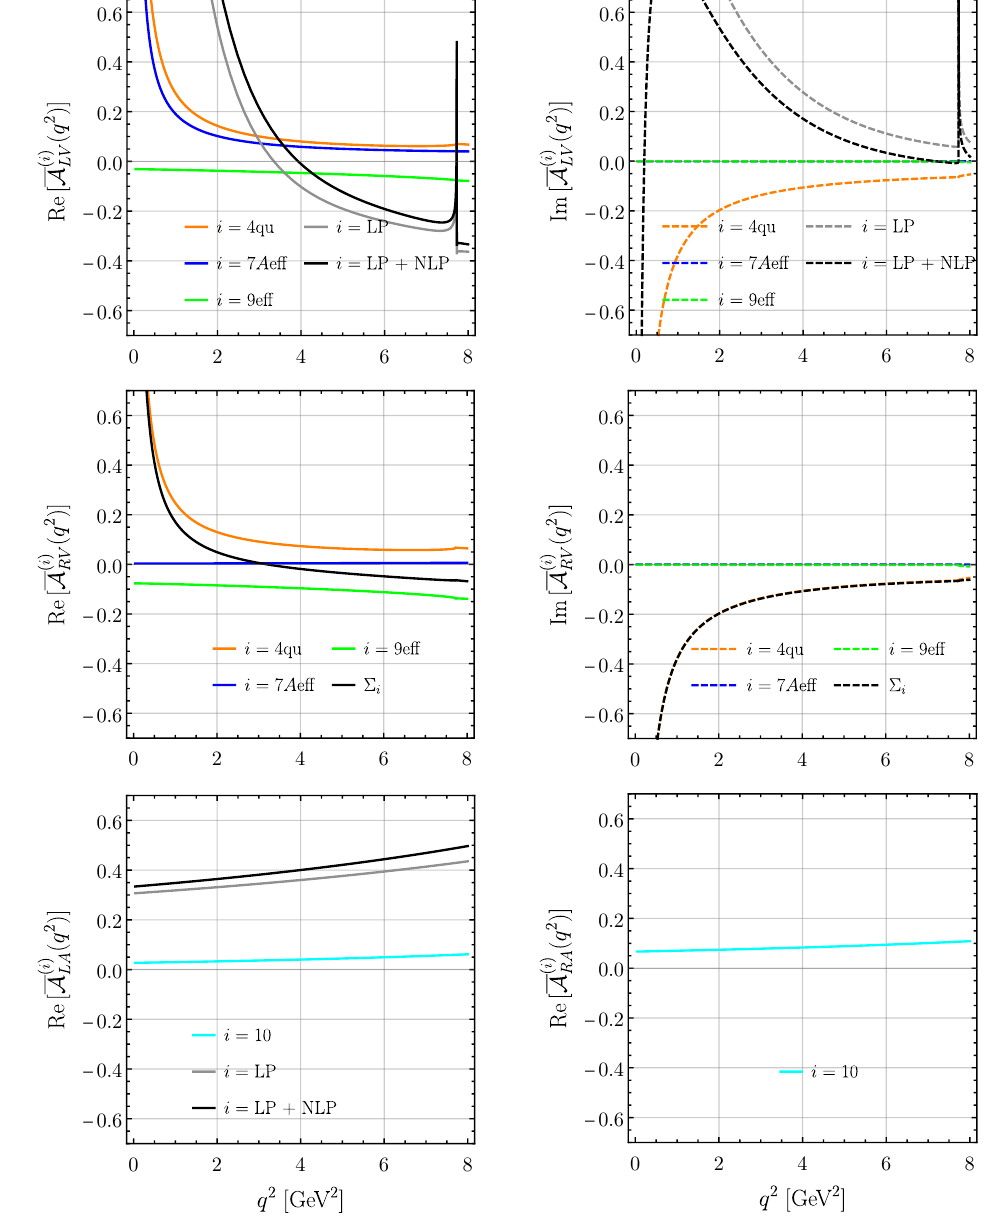
Figure 6 . The local and nonlocal A -type NLP contributions to the real [solid] and imaginary [dashed] parts of the helicity amplitudes A LV [upper], A RV [middle] and A hA with h = L, R [lower]. For comparison the LP [gray] and the total LP + NLP [black] results are also